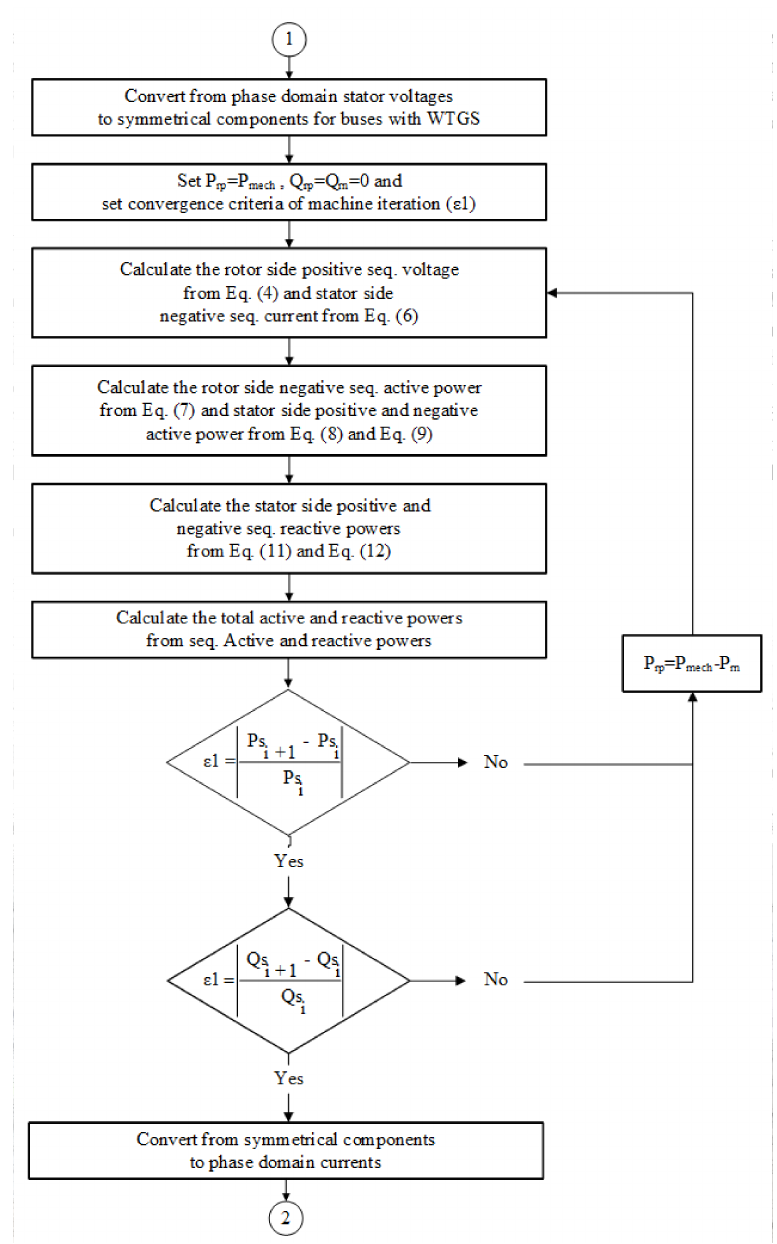
Figure 3. Flowchart of the Algorithm Implemented for the Developed